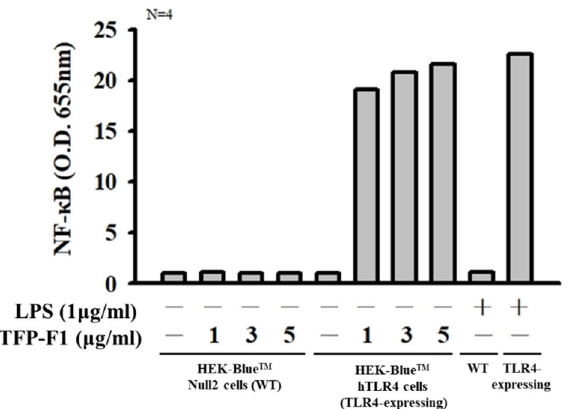
Figure 5. The activation levels of NF ‐κ B were measured by an NF ‐κ B reporter